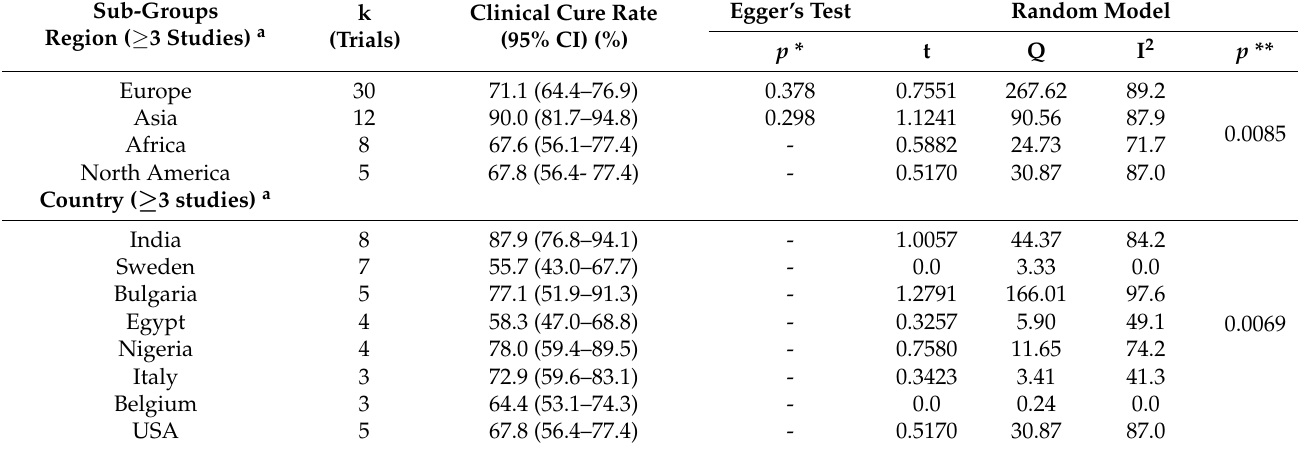
Table 5. Sub-group analysis of the efficacy in BV treatment in different regions and